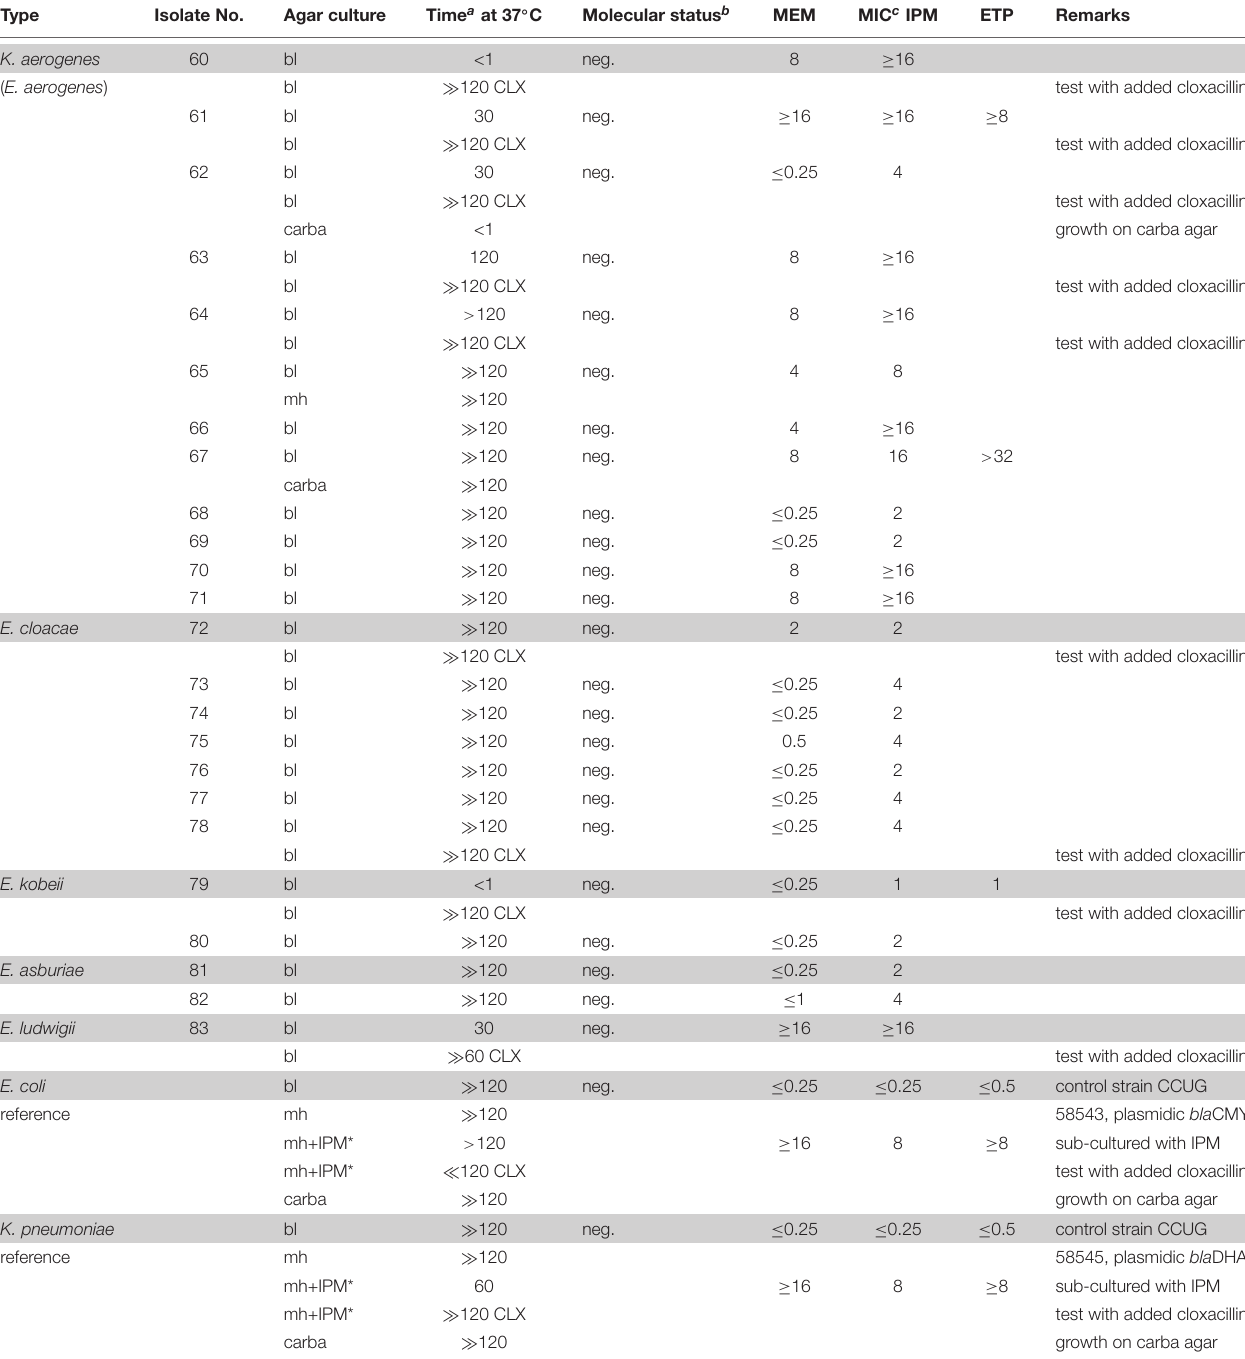
TABLE 3 | Isolates with potential AmpC beta-lactamase activity and negative molecular test for carbapenemase. Type Isolate